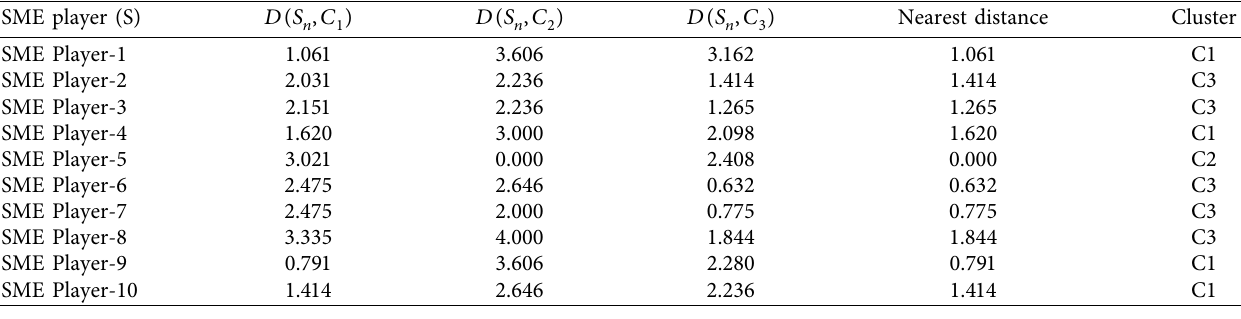
Table 20: Cluster group in second